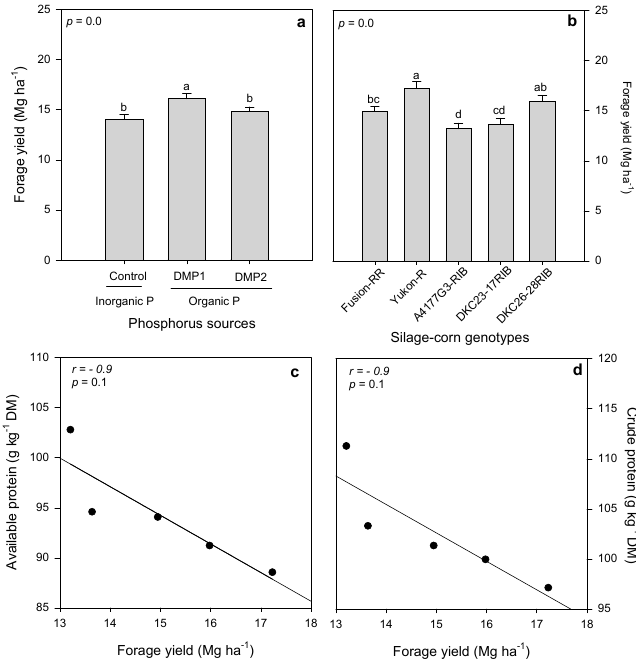
Figure 1. E ff ects of inorganic and organic phosphorus amendments on forage yield ( a ). Variation in forage production among silage-corn genotypes ( b ). Pearson’s correlation showing the association between forage yield and available protein ( c ) and crude protein ( d ) among five silage corn genotypes. Each bar represents mean of three replications ± SE.